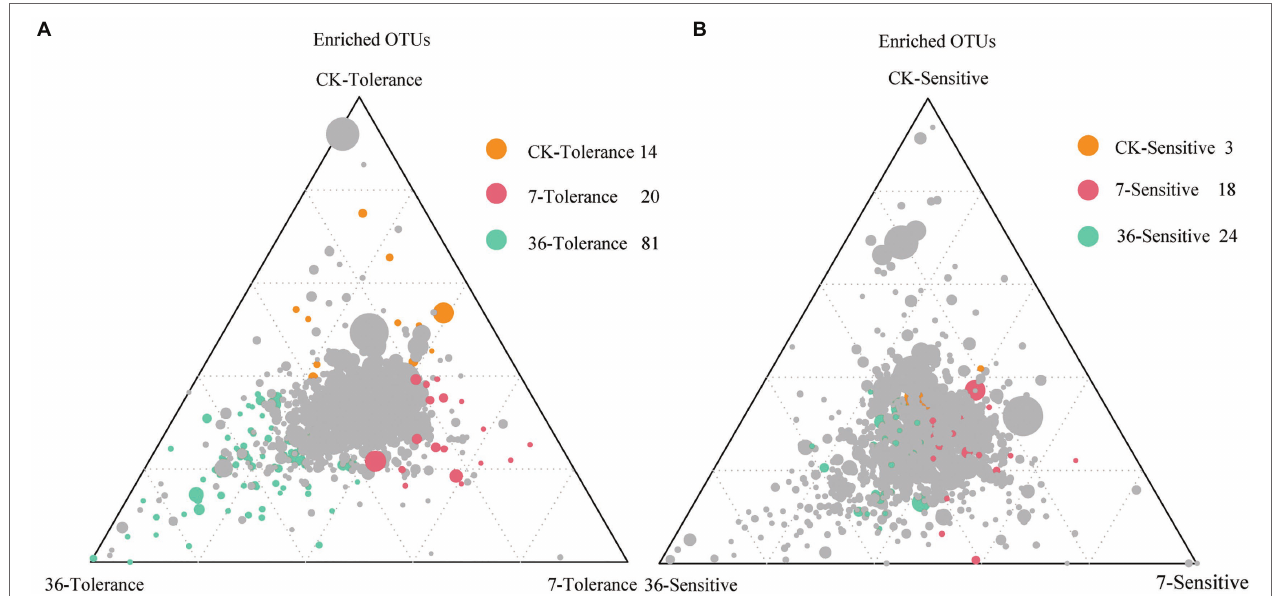
FIGURE 4 | Ternary plots depicting compartments showing the distributions of community differentiation among different cropping systems of tolerant (A) and sensitive (B) genotypes. The position of each circle depends on its contribution to the total relative abundance. Colored circles represent OTUs that enriched in different cropping systems, which the green for the rotation cropping system; red and green for 7- and 36-year continuous cropping systems, respectively. The gray circles represent the OTUs that are not significantly enriched within a given range.